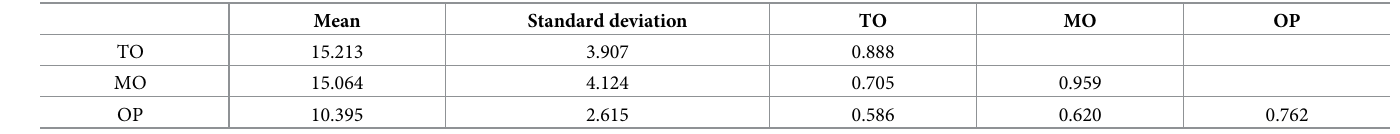
Table 4. Result of correlations and square root of AVEs (on the diagonal).